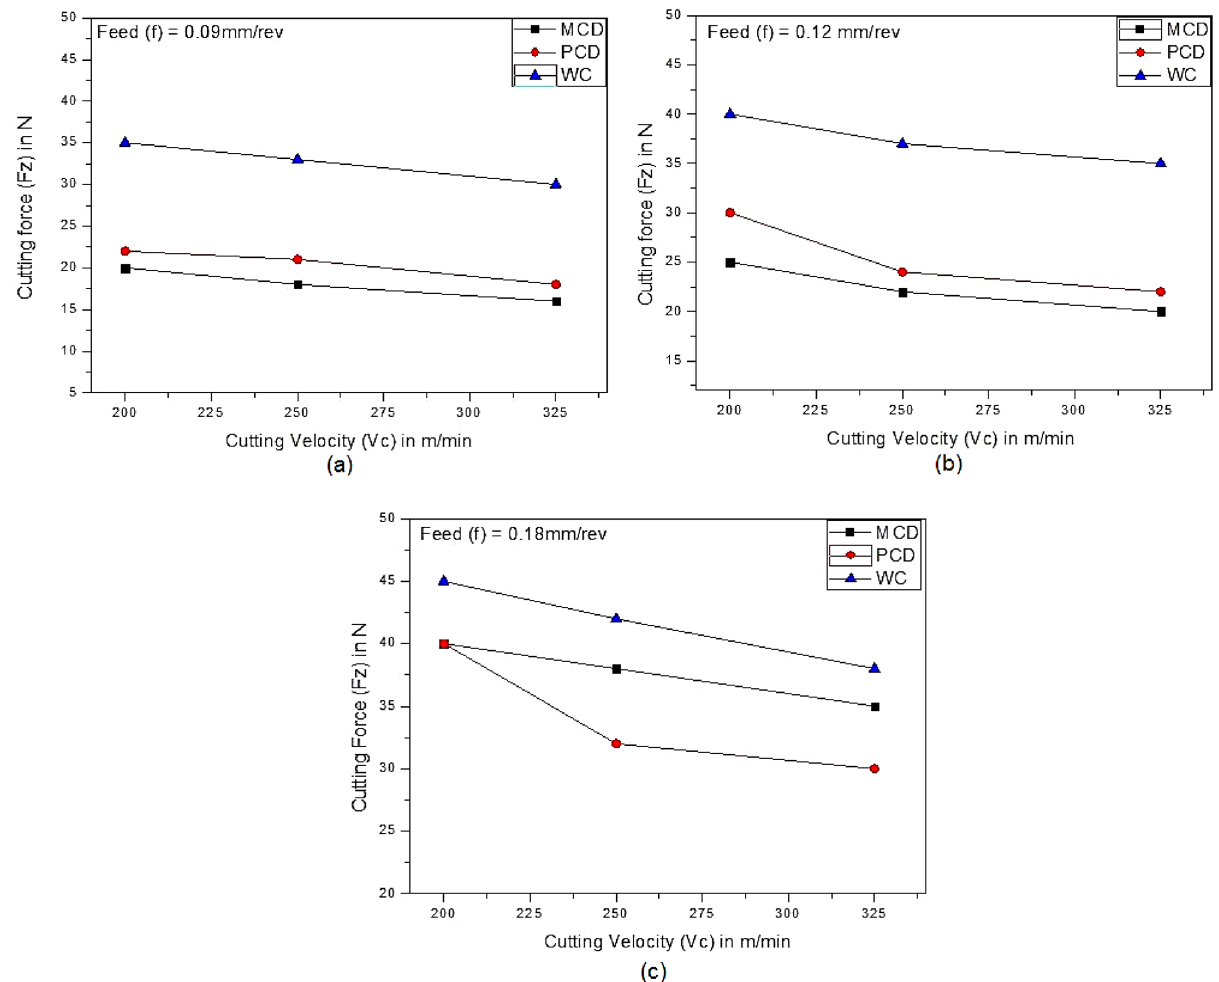
Fig. 15. Graph representing the cutting force values at various speed 200 m/min, 250m/min and 325m/min with constant cutting feed (a) 0.09mm/rev, (b) 0.12 mm/rev and (c) 0.18 mm/rev